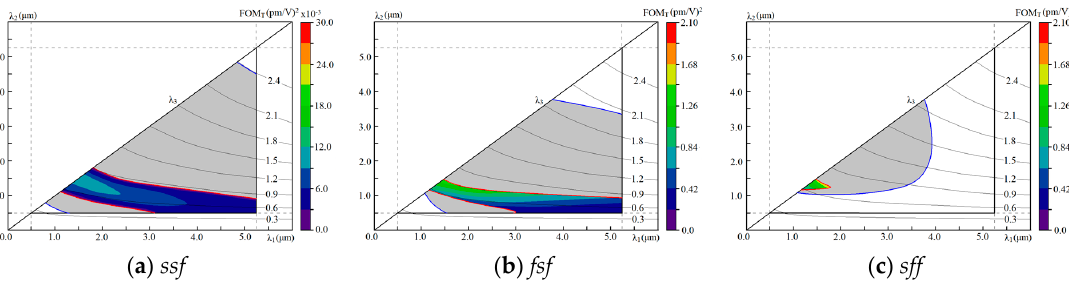
Figure 14. FOM T ( λ 1 , λ 2 ) distributions for KTA crystal for all types of interactions: ( a ) ssf , ( b ) fsf , ( c ) sff .